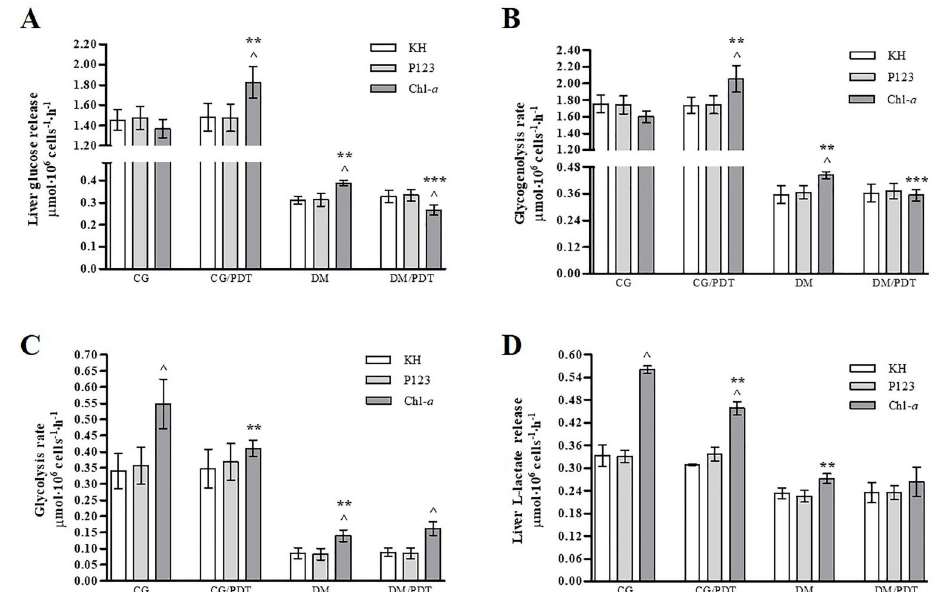
Figure 2. Glucose release ( A ), glycogenolysis ( B ), glycolysis rates ( C ), and L-lactate release ( D ) from isolated hepatocytes of Wistar rats. KH: hepatocytes incubated with Krebs/Henseleit-bicarbonate buffer; P123: hepatocytes incubated with empty micellar copolymers; Chl -a ; hepatocytes incubated with chlorophyll- a (1.25 mg/L). CG: control animals without light irradiation; CG/PDT: control animals with light irradiation; DM: type 1 diabetic animals without light irradiation; DM/PDT: diabetic animals with light irradiation. Data reported as means ± SD, n=5/group. ̂ P o 0.05 vs KH and P123 of the same group, **P o 0.05 vs Chl -a CG, ***P o 0.05 vs Chl -a DM (one-way